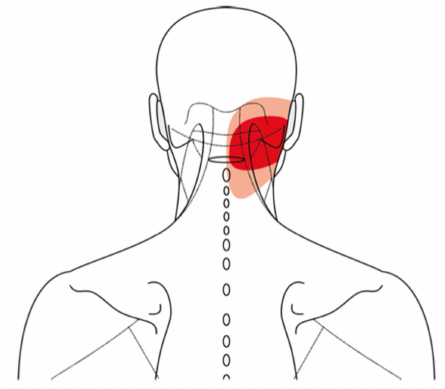
Figure 1. Patient neck pain and headache